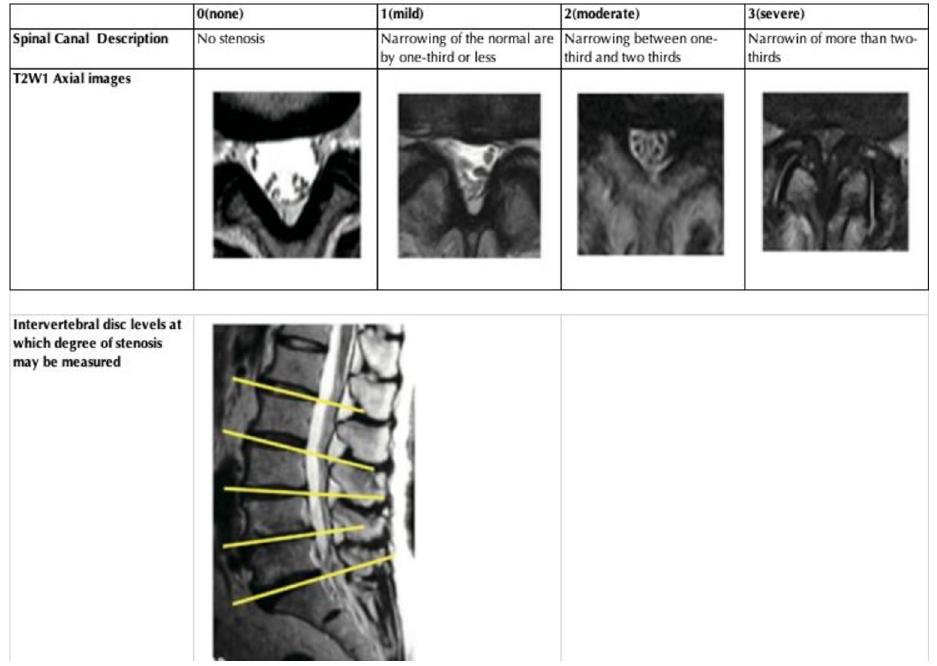
Fig 2. Qualitative central stenosis grading [24].